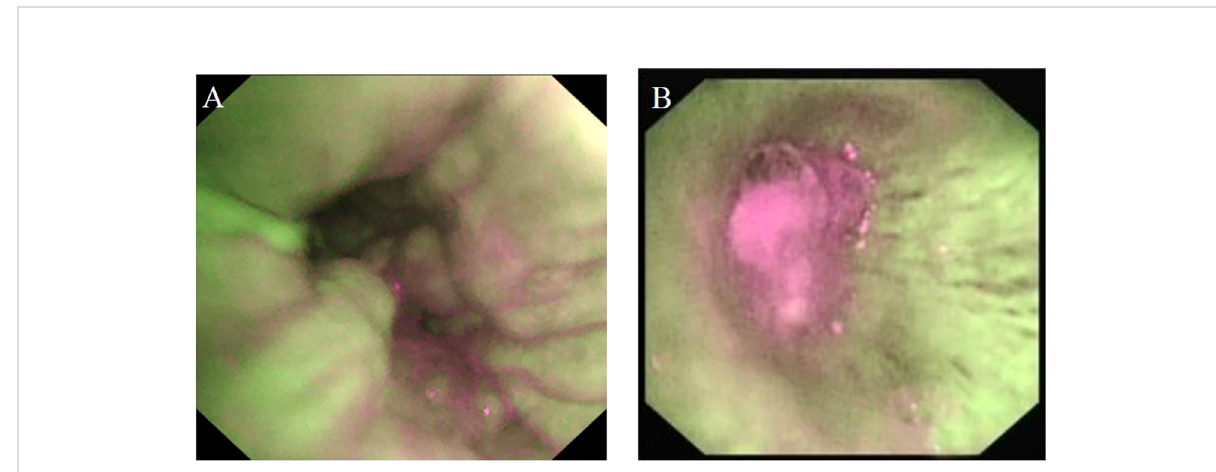
FIGURE 2 The AFB image feature of benign and malignant bronchial lesions. (A) : benign bronchial lesions. (B) : malignant bronchial